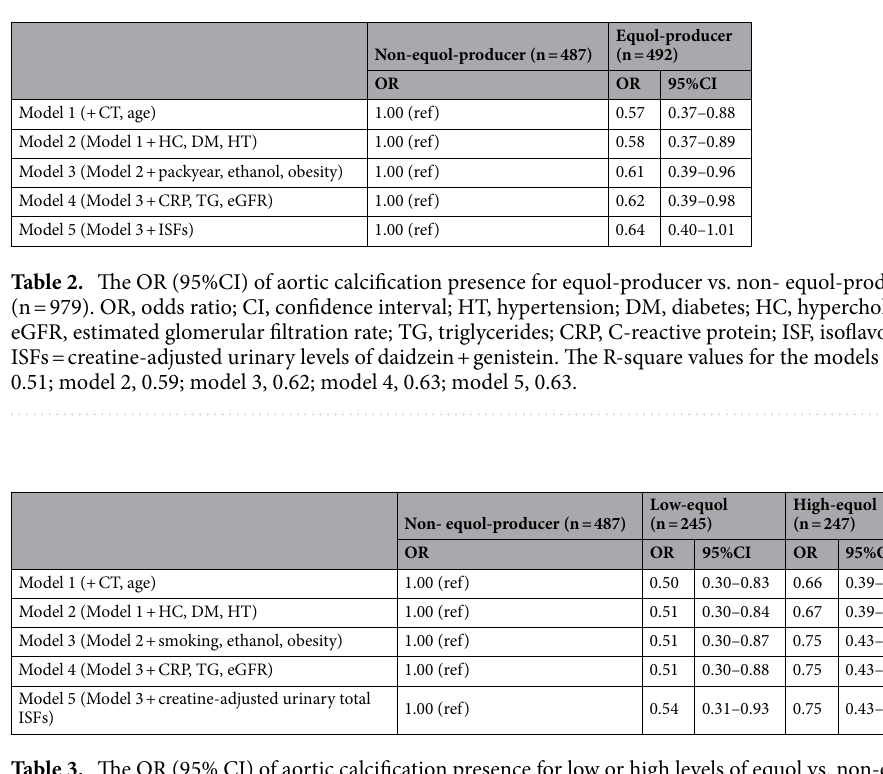
Table 3. The OR (95% CI) of aortic calcification presence for low or high levels of equol vs. non-equol- producer (n = 979). OR, odds ratio; CI, confidence interval; CT, computerized tomography; HT, hypertension; DM, diabetes; HC, hypercholesterolemia; eGFR, estimated glomerular filtration rate; TG, triglycerides; CRP, C-reactive protein; ISFs, isoflavones. Median (25th–75th) of equol among low-equol group is 992 (279–2179); among high-equol group is 11,072 (6478–20,477).